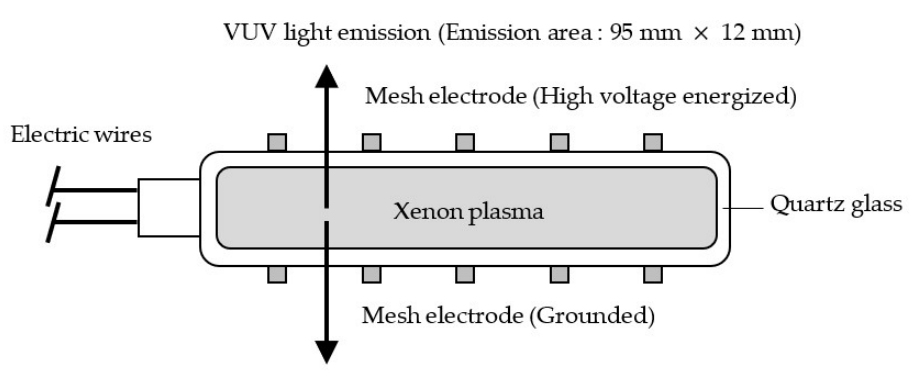
Figure 1. The structure of the xenon excimer lamp.